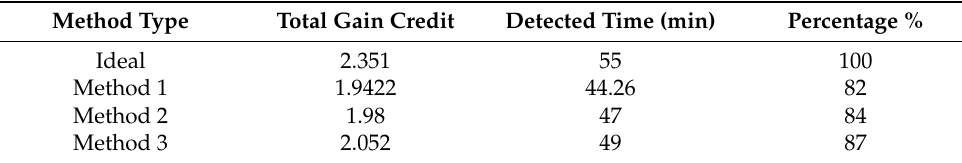
Table 4. Results of the three methods used to calculate physical activity credit gain.